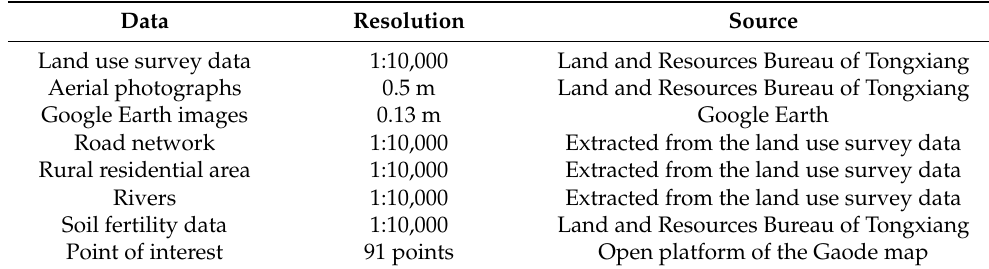
Table 1. Description of the data used in this paper.